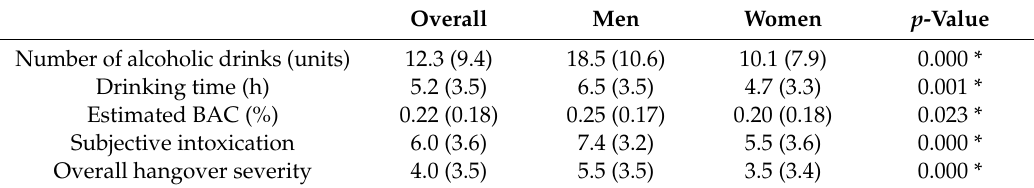
Table 2. Past month heaviest drinking